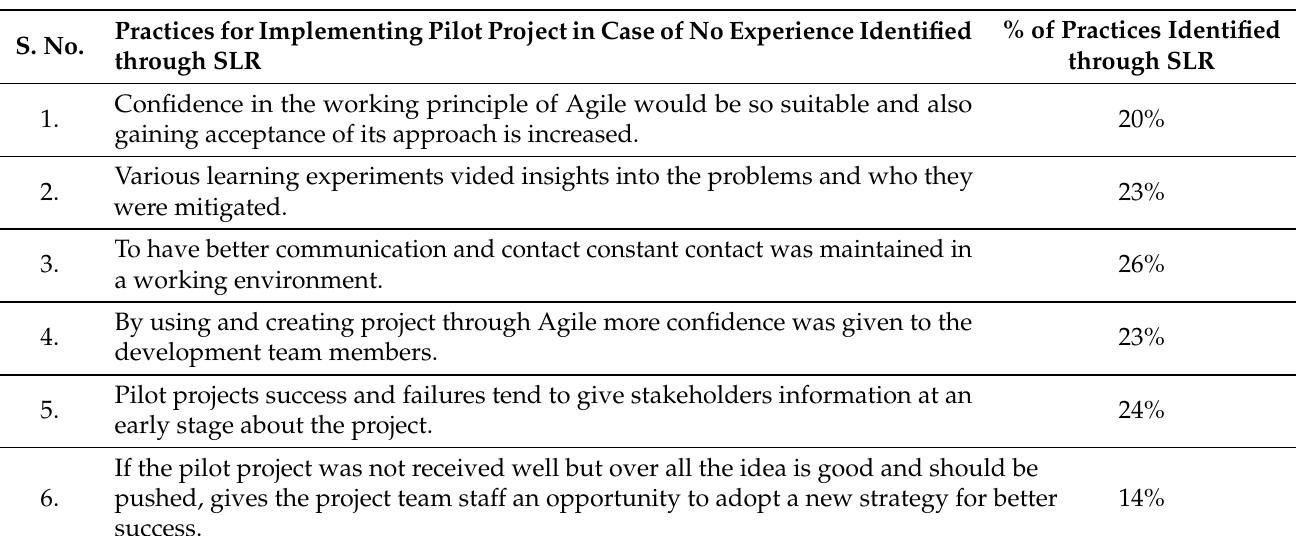
Table 21. Practices for implementing pilot project in case of no